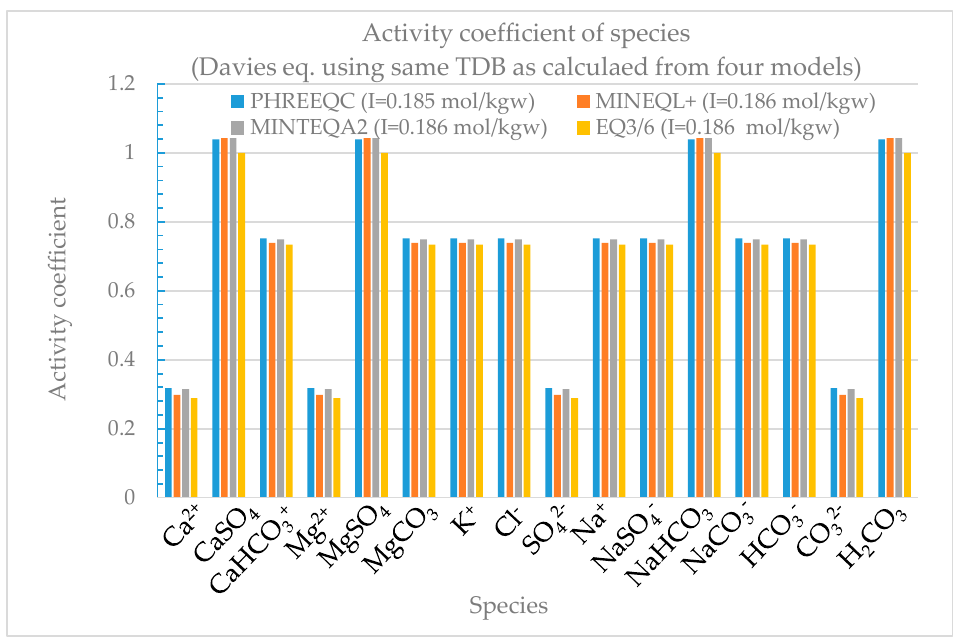
Figure 9. The solution concentration calculated by the Davies equation using the same thermody- namic database of the four models.